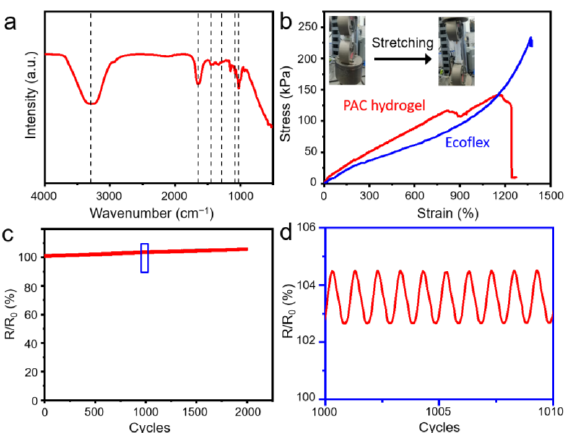
Figure 2. ( a ) FTIR spectra of the PAC hydrogels. ( b ) Strain–stress test of the PAC hydrogels and Ecoflex thin film. Durability loading–unloading test of PAC hydrogel for ( c ) over 2000 cycles at 2 Hz and ( d ) the high-resolution graph from the 1000 th to the 1010 th cycles.